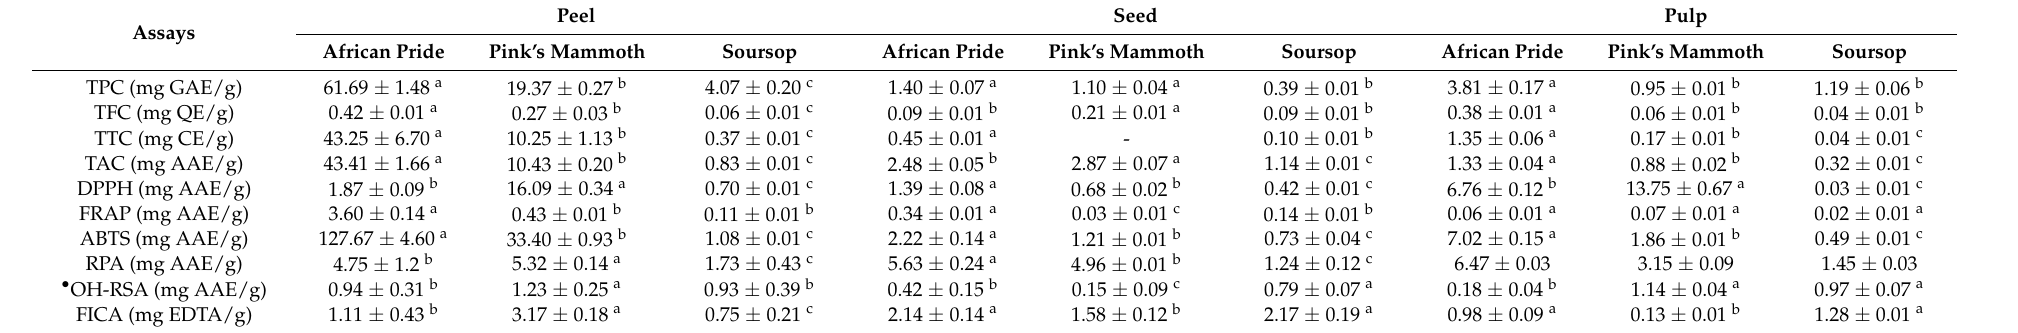
Table 1. Estimation of phenolic content and antioxidant potential of different custard apple